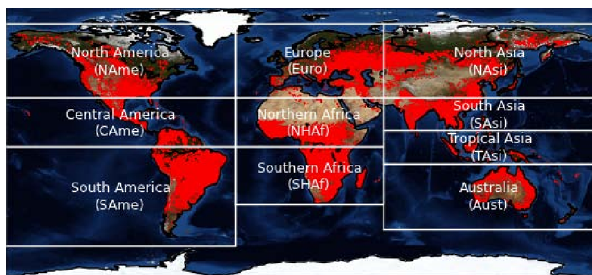
Figure 2. Regions of interest as defined in Kaiser et al.